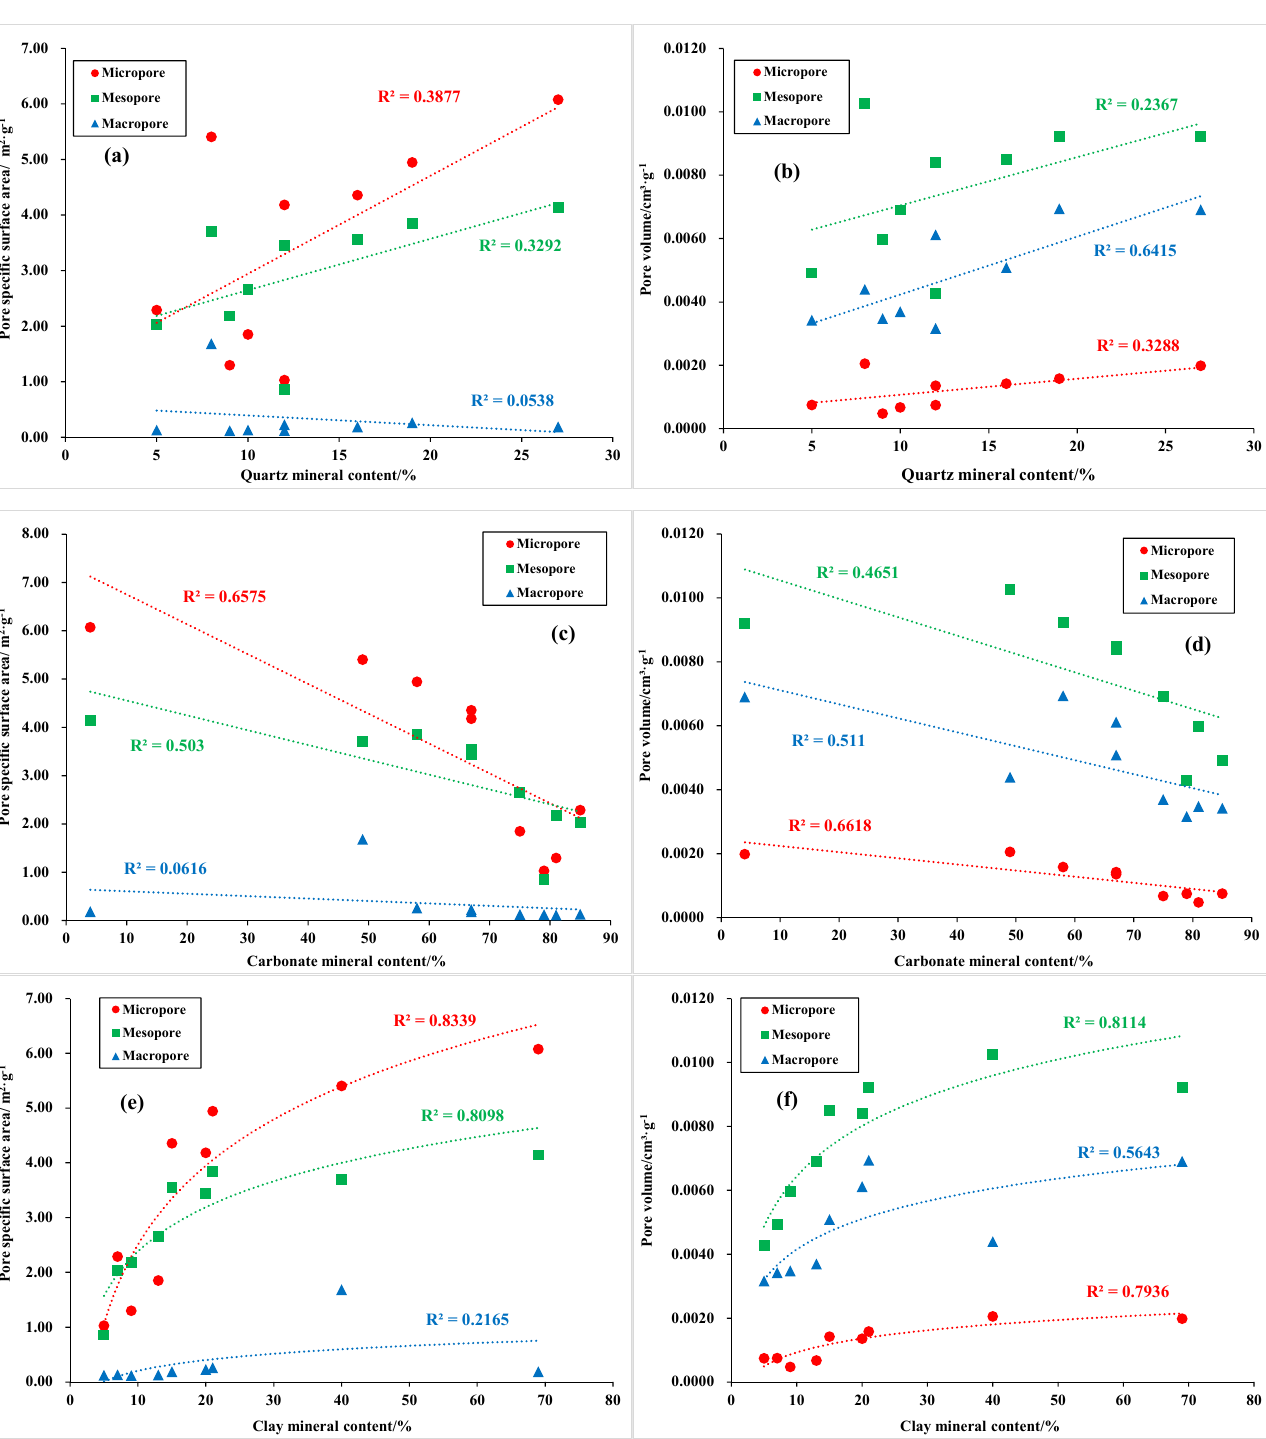
Figure 10. Relationship between pore-specific surface area, pore volume and quartz, carbonate and clay minerals of shale in the Qianxi area. ( a ) Relationship between pore-specific surface area and Quartz mineral content; ( b ) Relationship between pore volume and Quartz mineral content; ( c ) Relationship between pore-specific surface area and Carbonate mineral content; ( d ) Relationship between pore volume and Carbonate mineral content; ( e ) Relationship between pore-specific surface area and Clay mineral content; ( f ) Relationship between pore volume and Clay mineral content.